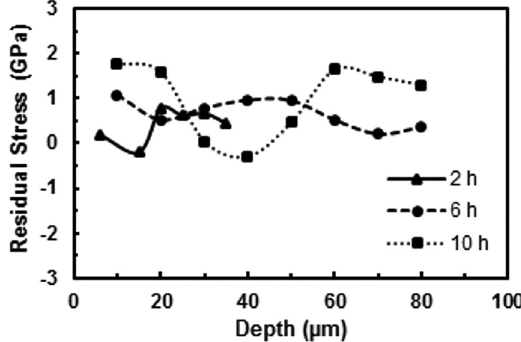
Figure 6. Residual stresses obtained by indentation using the Chen equation 11 in FeB and Fe B phases formed on AISI 304 2